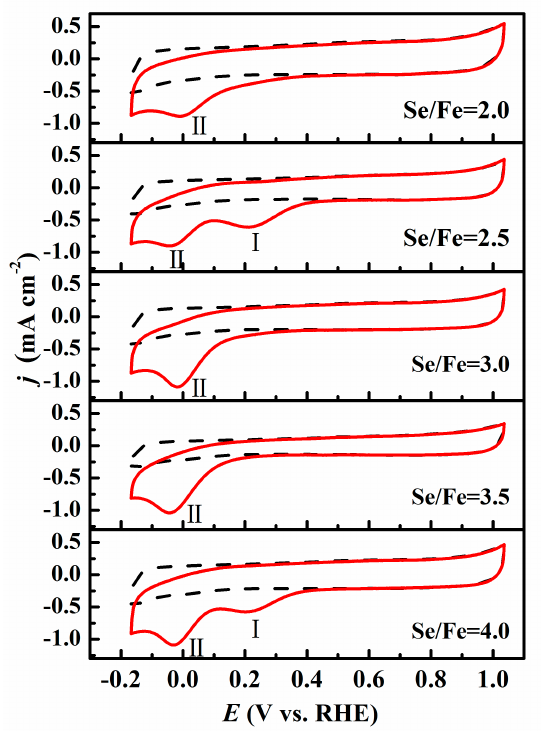
Figure 2. Cyclic voltammograms of FeSe 2 /C prepared with different Se/Fe ratios in N 2 (dashed lines) and O 2 (solid lines) saturated 0.1 mol·L − 1 HClO 4 solutions at 50 mV·s − 1